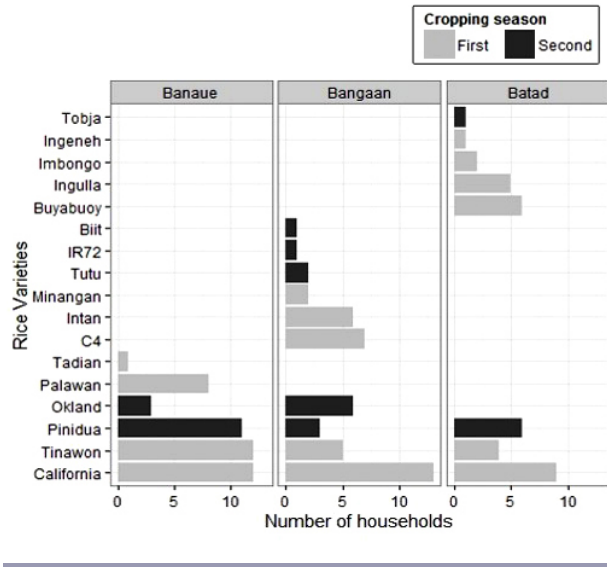
Fig. 4 . Varieties of nonglutinous rice cultivated among the surveyed households (n = 30 in each Barangay) at the three study sites. Tinawon and pinidua, meaning “yearly” and “second crop,” respectively, are two categories that may include several autochthonous varieties that are not differentiated by local